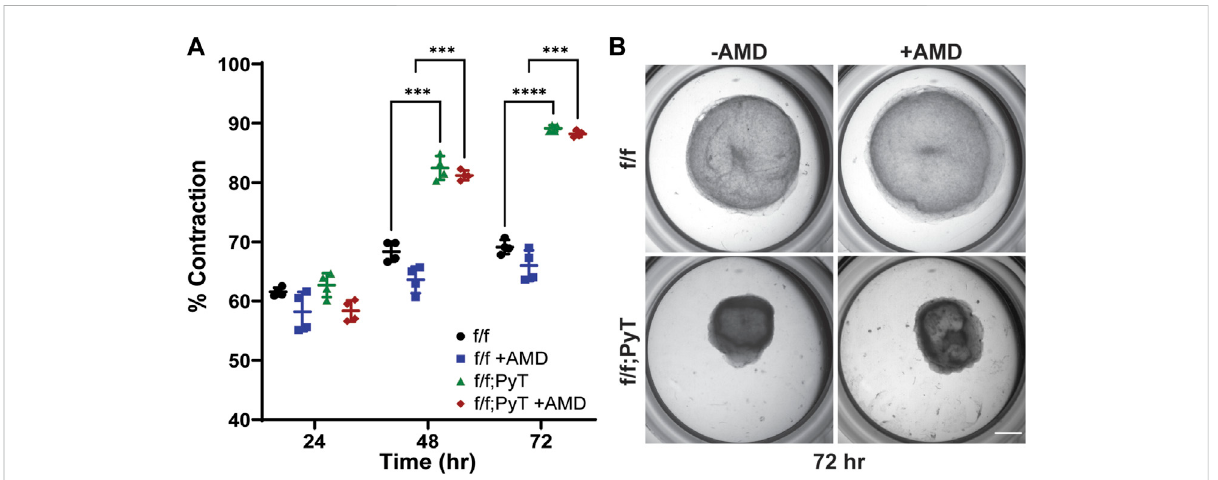
FIGURE 3 Collagen gel contraction assay to determine fi broblast contractility. (A) Percent contraction of normal mouse mammary gland fi broblasts (f/f) and CAFs (f/f; PyT) harvested from PyT tumor-induced mice, with and without the pharmacological CXCR4 inhibitor, AMD3100 (AMD). CAFs exhibit greater contractility compared to their normal counterparts by 48 h. AMD did not have a statistically signi fi cant effect on fi broblast contraction, although a slight reduction in mean contraction is observed for both cell lines. Reported values represent the mean ± standard deviation,